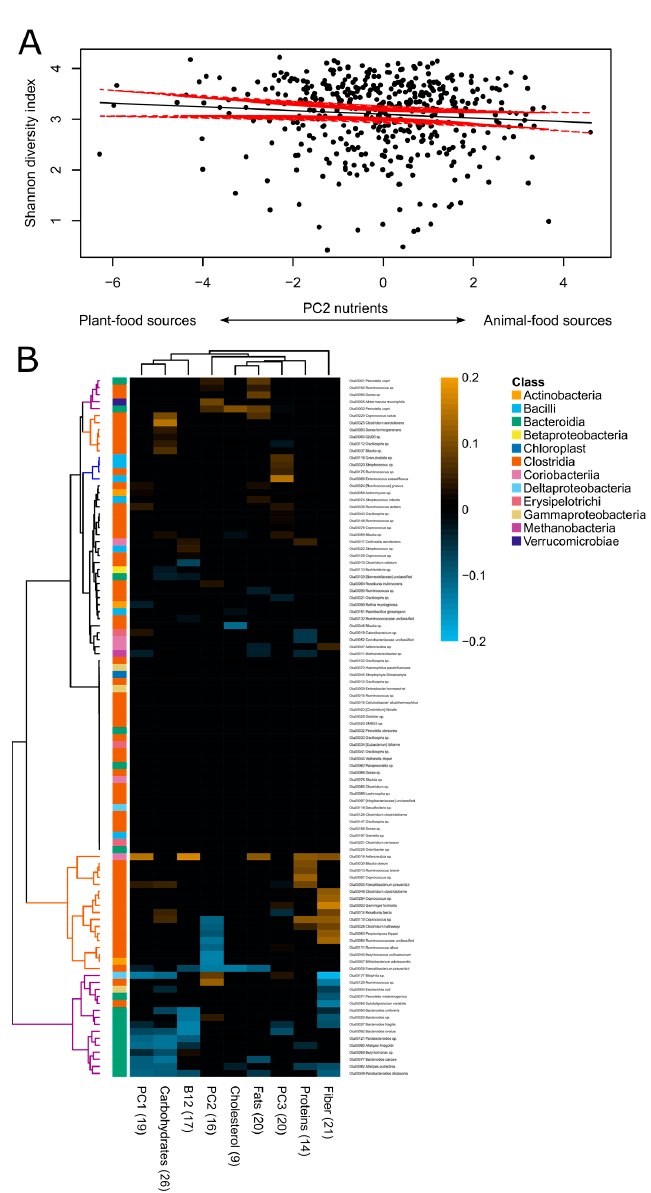
Figure 5. Associations between nutrient intake and gut microbiota. ( A ) Correlation between the gut microbiota alpha diversity (Shannon diversity index) and nutrient intake (regression line with 95% confidence intervals). PC2 ( x -axis) provides information about the sources of nutrients: negative values indicate nutrients obtained mainly from plant-food sources, whereas positive values are associated with nutrients obtained mainly from animal-food sources. ( B ) Heatmap showing Spearman’s correlation coe ffi cients between OTU relative abundance and nutrient intake. The set of OTUs associated with multivariable-adjusted nutrient intake were obtained with a regression-based random-forest machine-learning algorithm. We also included the first three components of the nutrient PCA. Dendrograms obtained by hierarchical Ward-linkage clustering. The colored branches of the dendrogram are for illustrative purposes: brown branches highlight OTUs associated with nutrients mainly obtained from plant-food sources, purple branches highlight OTUs associated with nutrients mainly obtained from animal-food sources and blue branches highlight OTUs associated with PC3 (i.e., vitamins of the B complex). The taxonomic classification at the class level of each OTU is noted on the left side of the heatmap. Values in parentheses in the x -axis indicate the number of OTUs selected by the random